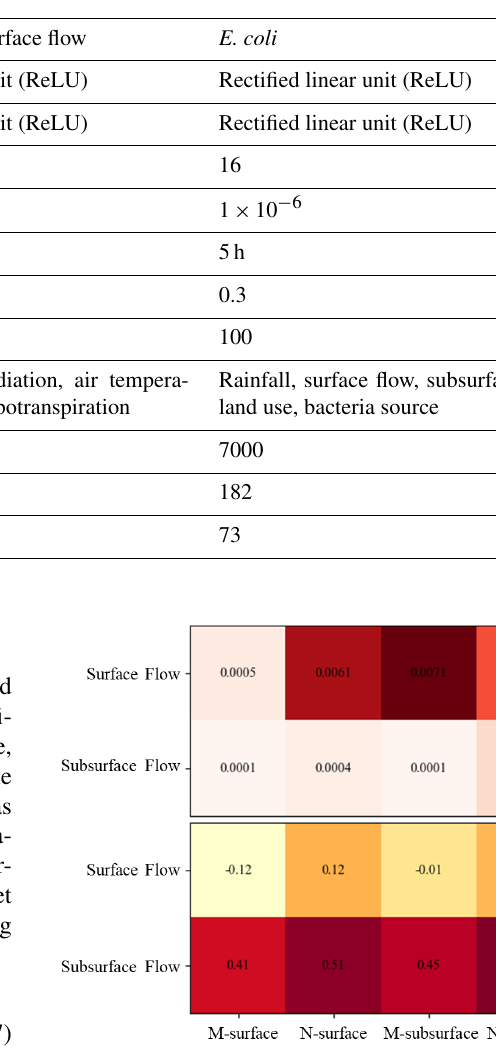
Table 2. Hyperparameters of LSTM for surface flow, subsurface flow, and E. coli concentration simulation.